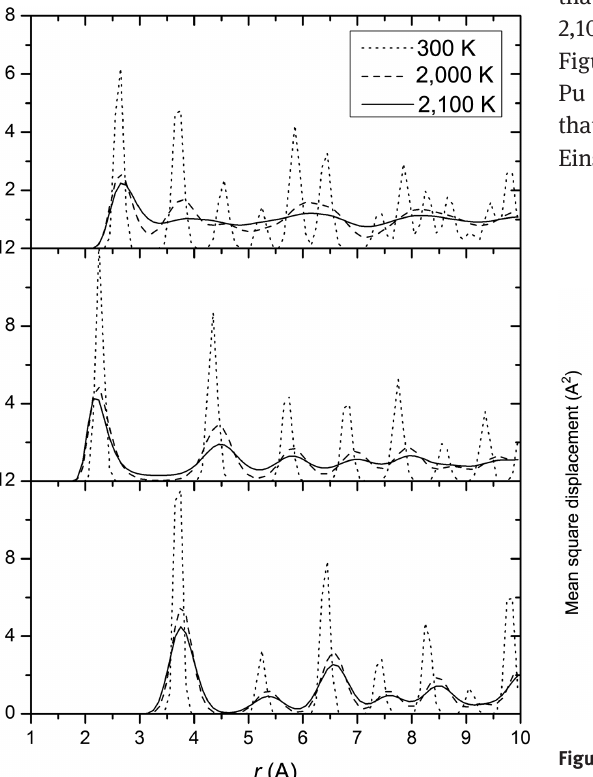
Figure 3: Pair correlation functions of PuO 2 at three different temperatures.